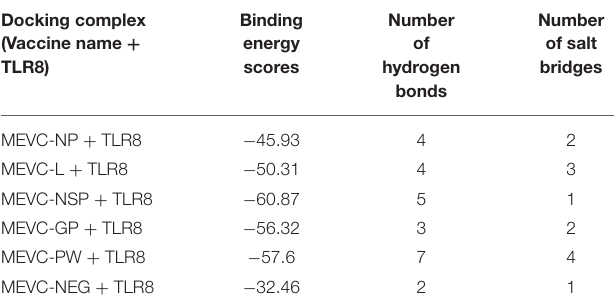
TABLE 8 | Details of binding scores and identified interaction patterns between the different MEVCS and human TLR8. Docking complex (Vaccine name